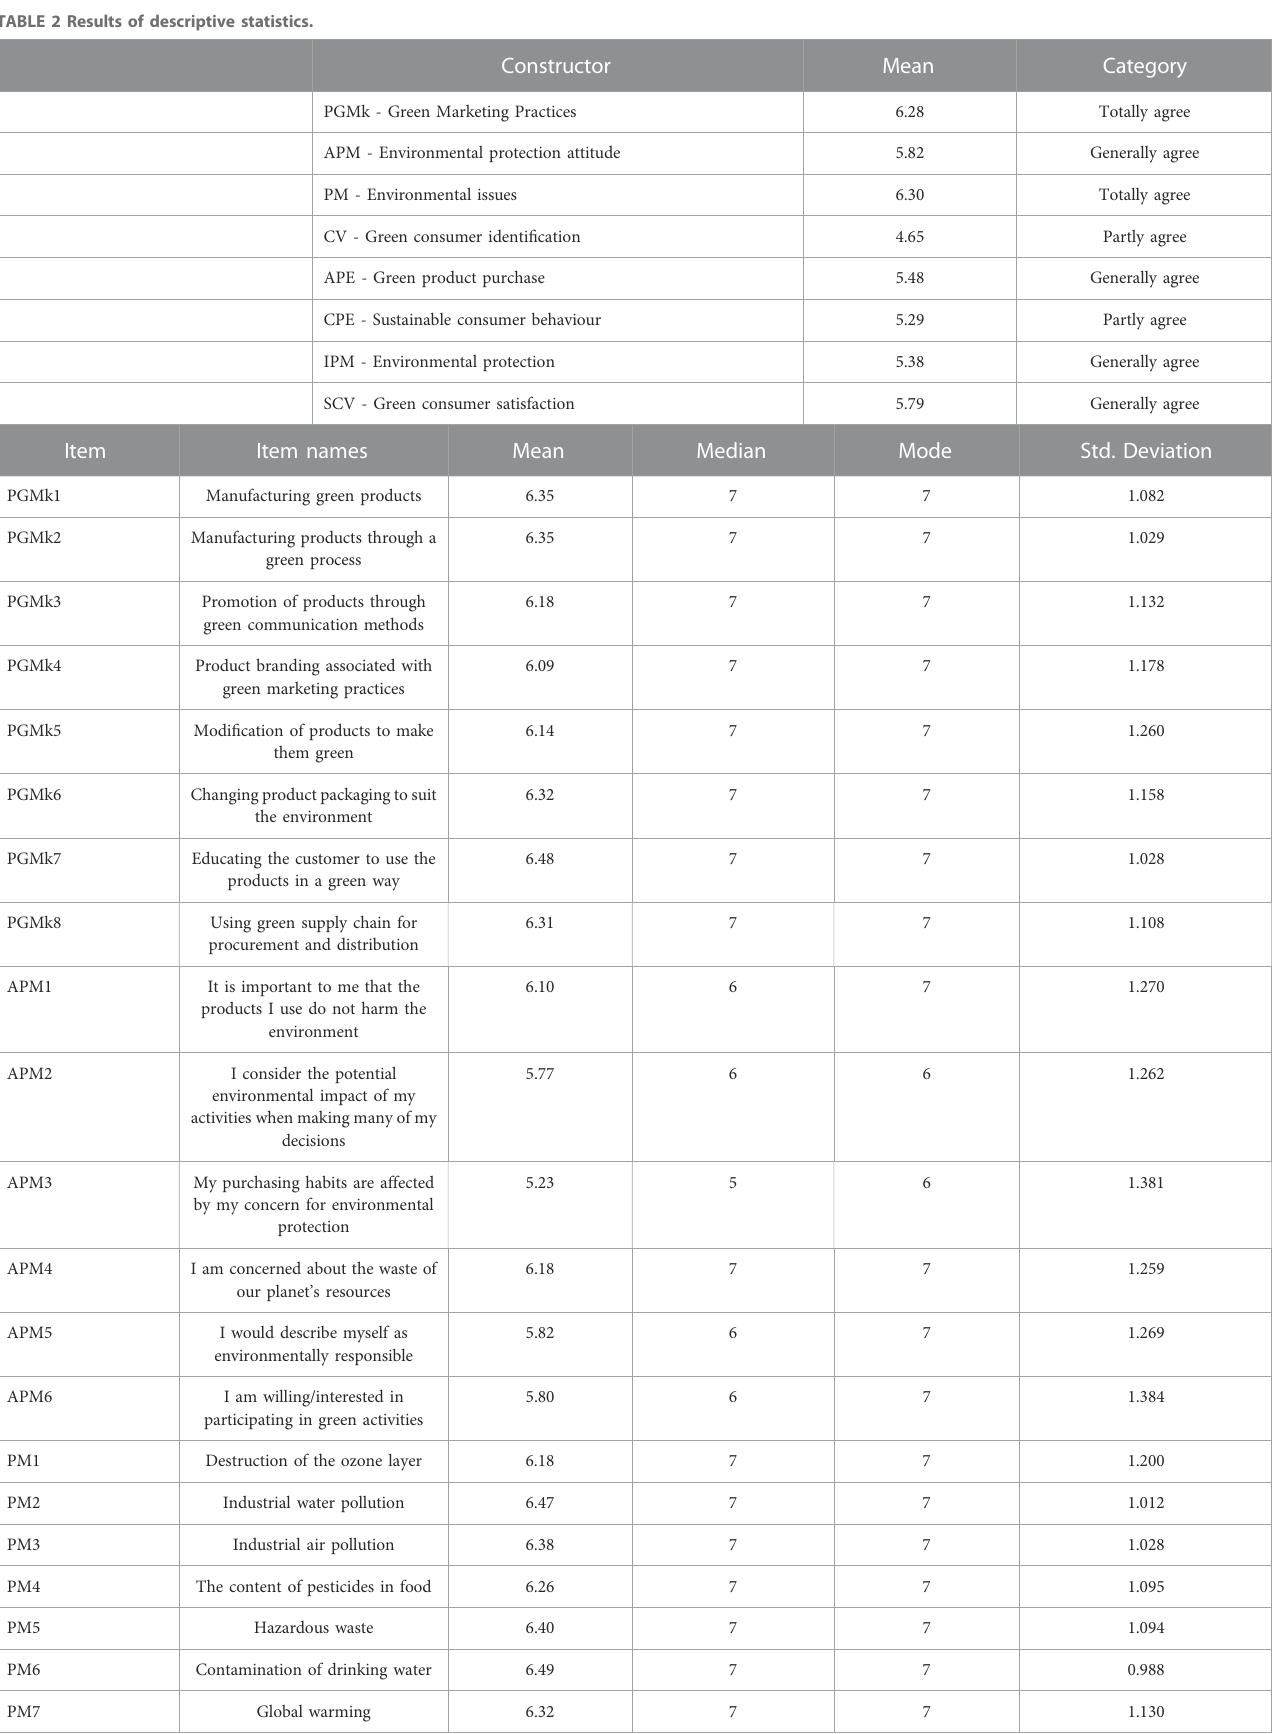
TABLE 2 Results of descriptive